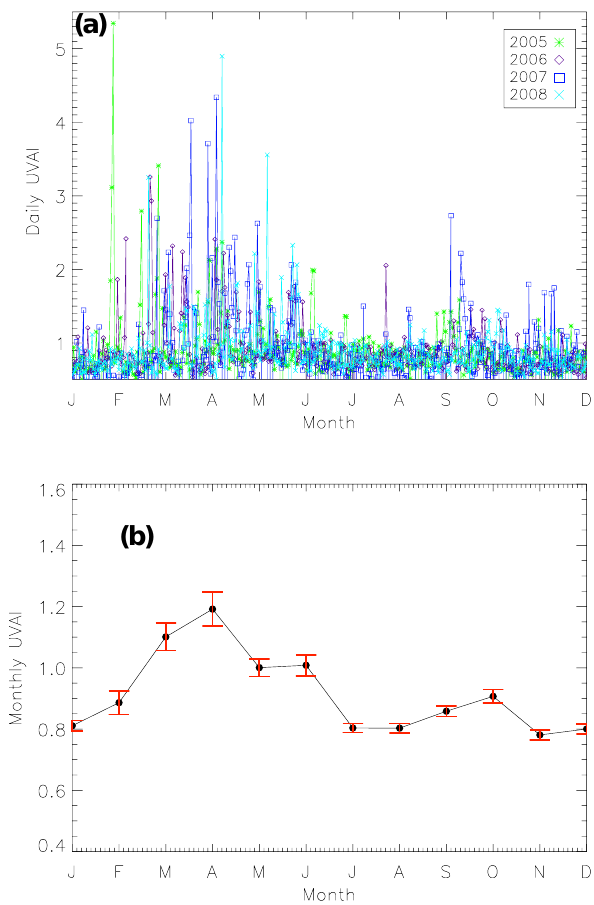
Fig. 5. (a) the monthly climatology means of UVAI over Nile Delta for four years (2005–2008) and (b) is Daily OMI UVAI for 2005– 2008. The vertical bars represent standard